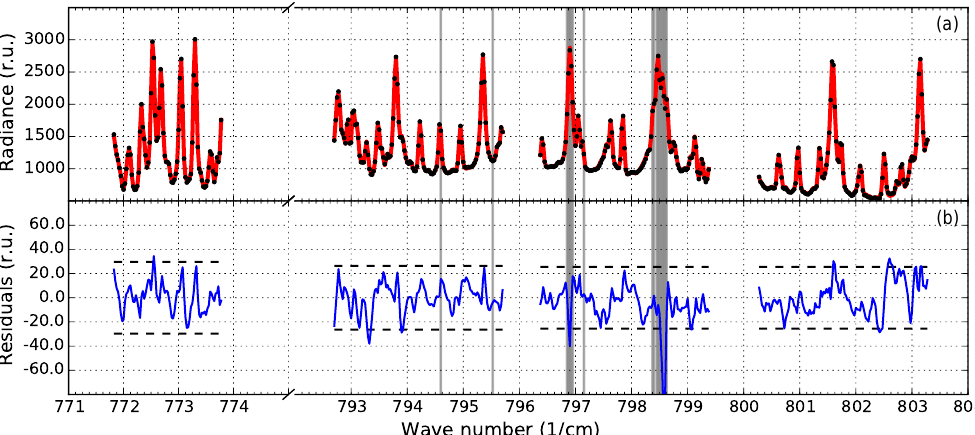
Figure 3. Panel (a) shows an average of 1141 observed (black dots) and simulated (red line) limb radiances in the MWs used for CCl 4 FR retrievals. The averages include spectra with tangent heights from 6 to 17km. Panel (b) shows the average residuals of the fit (blue line, observation minus simulation) as well as the average noise level of the individual measurements (dashed lines). The grey areas indicate spectral channels excluded from the fit. The radiance units (r.u.) in the vertical axes of the plots are nW / (cm 2 srcm − 1 ) .